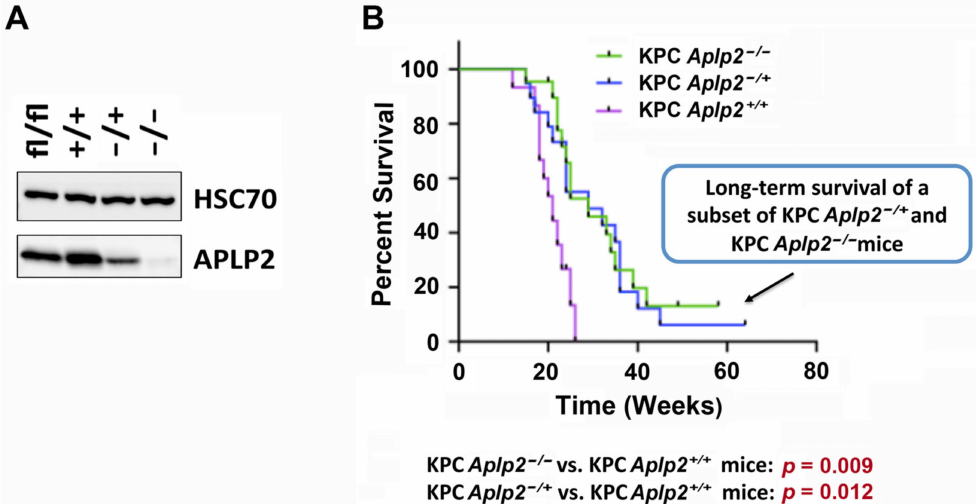
Figure 3. Novel variants of KPC mice with pancreas-specific APLP2 heterozygous or homozygous loss exhibited prolonged survival. ( A ) Expression of APLP2 in pancreatic tissue samples from mouse strains. Immunoblotting to detect HSC70 as a control (~70 kD), as well as the APLP2 C-terminus (~22 kD), was performed on pancreas tissue lysates from KPC mice with floxed (fl/fl), wild-type (+/+), heterozygous deletion ( − /+), or homozygous deletion ( − / − ) of APLP2. The densitometry readings and intensity ratios for these bands are shown in Table S2. ( B ) Pancreas-specific loss of APLP2 prolongs the survival of KPC mice. The graph displays cumulative survival time in weeks with Week 0 indicating birth. The mice were monitored at least 3 times weekly and euthanized per Institutional Animal Care and Use Committee (IACUC) guidelines. Mean survival time +/ − standard error of the mean was determined for each